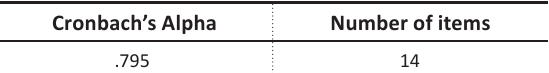
Table 1. Reliability